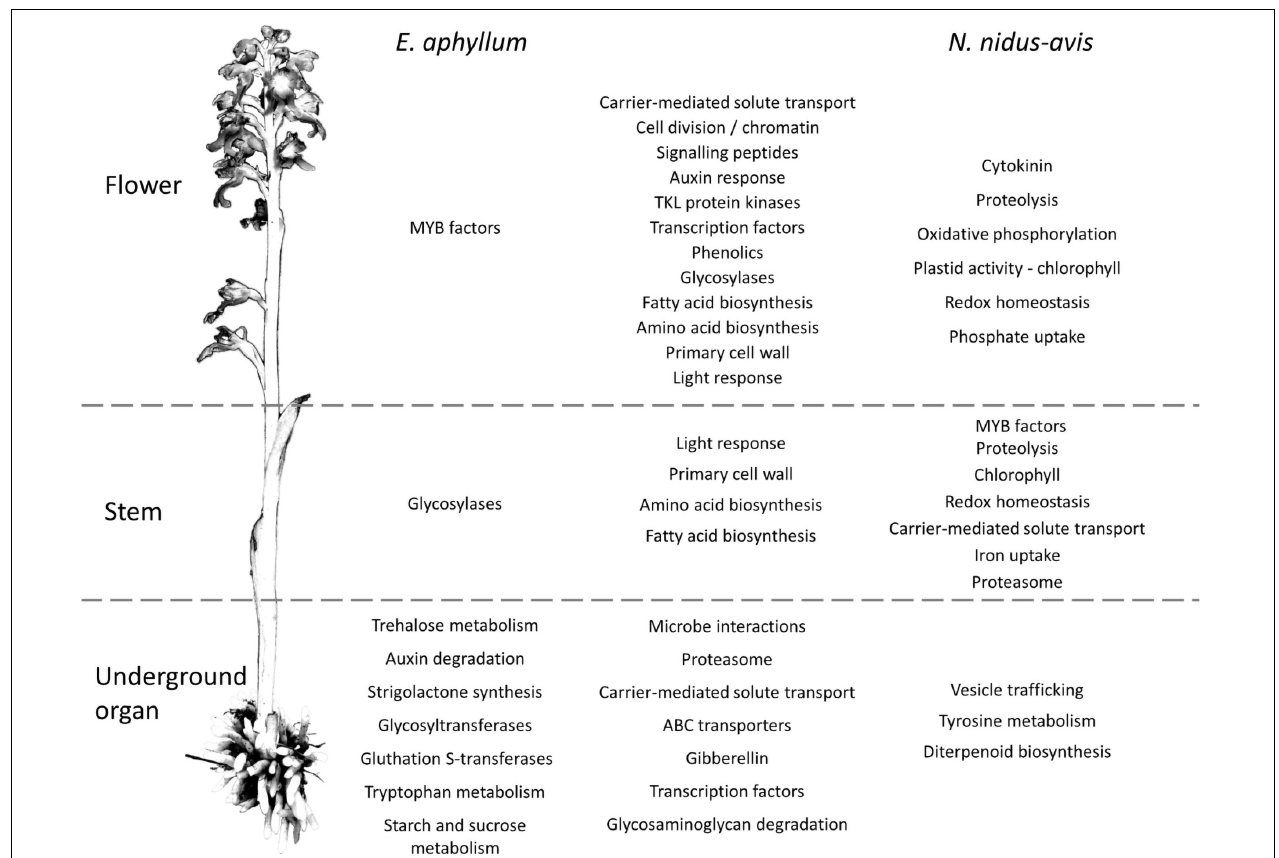
FIGURE 3 | Pathways differentially expressed between organs in E. aphyllum and N. nidus-avis . Summary of the enrichment analysis of the transcriptomic expression profiles ( Supplementary Data 5 ). A pathway is indicated in the organ(s) where its activity peaks. The common changes are shown in the central column while the changes specific to E. aphyllum are shown in the left column and those specific to N. nidus-avis in the right column. The terms are mostly derived from the Mapman4 and KEGG pathways.